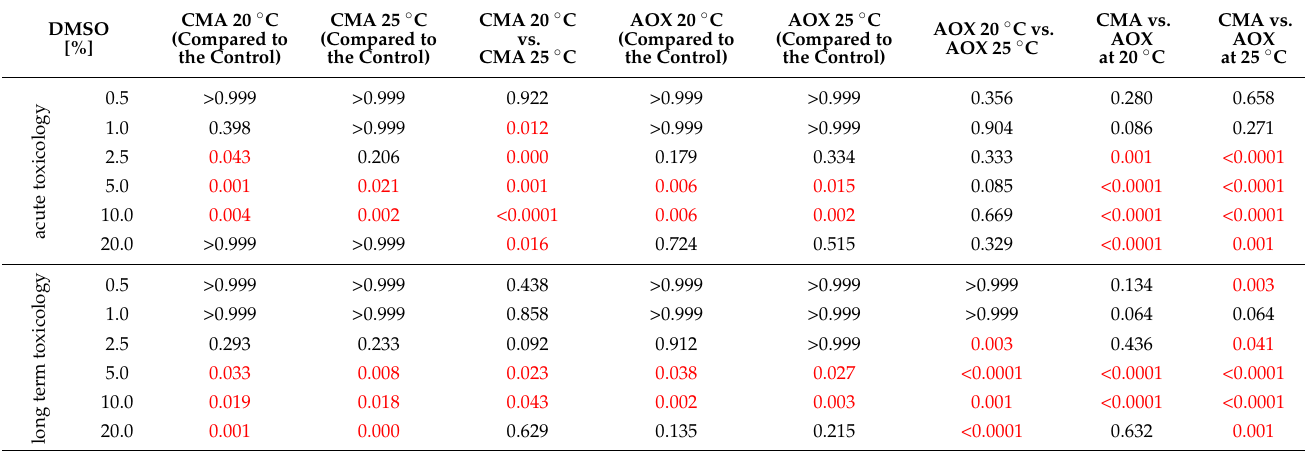
Table 3. Statistical evaluation of percentage mortality rates due to increasing dimethyl sulfoxide (DMSO) concentrations in intra- and interspecies comparison of Atlantic sturgeon (AOXlar7y, AOX) and maraena whitefish (CMAfin1, CMA) at cultivation temperatures 20 and 25 ◦ C. Significant different p values (<0.05) highlighted in